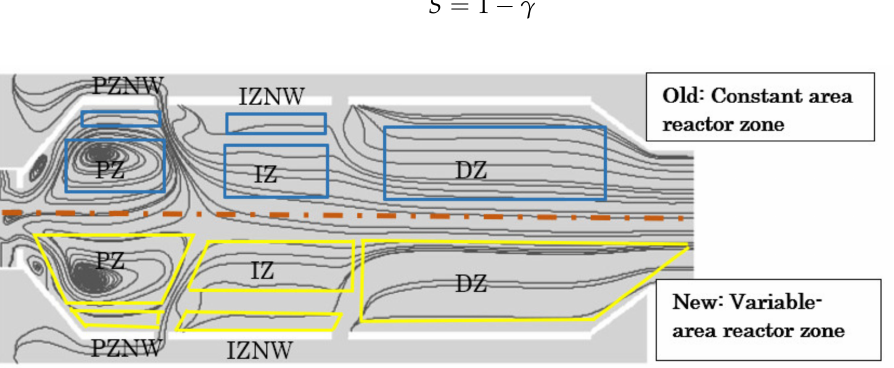
Figure 18. Reactor layout refinement with variable